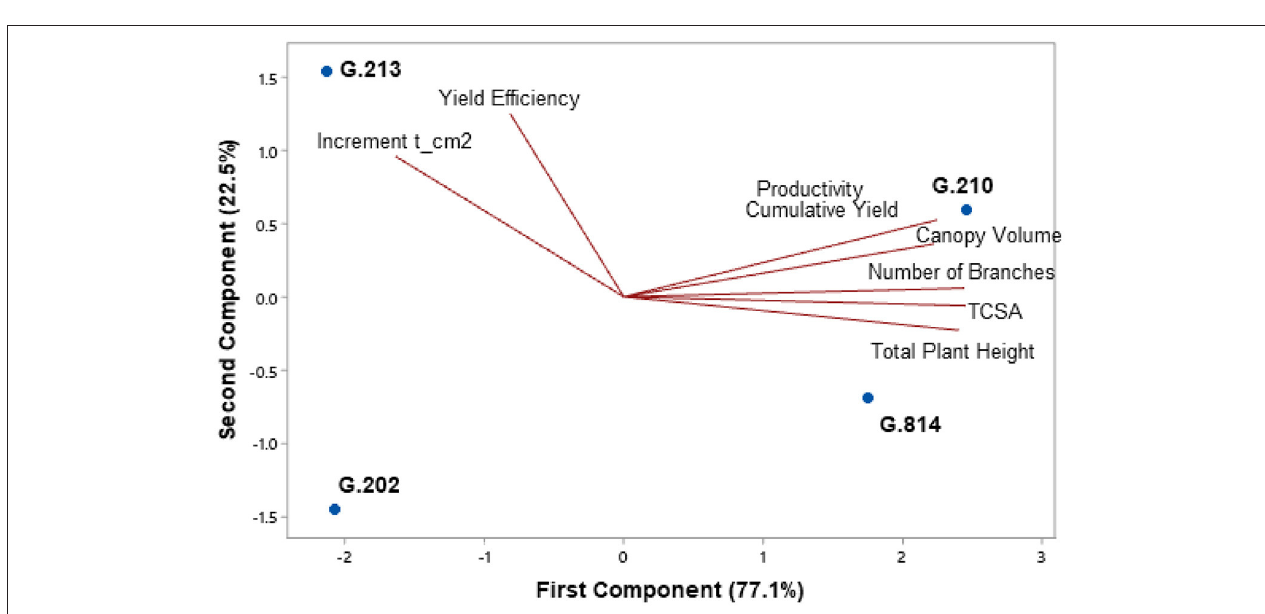
FIGURE 4 | Vigor-productivity-efficiency relationship of the Fuji Suprema cultivar on the Geneva ® series rootstocks. São Joaquim –